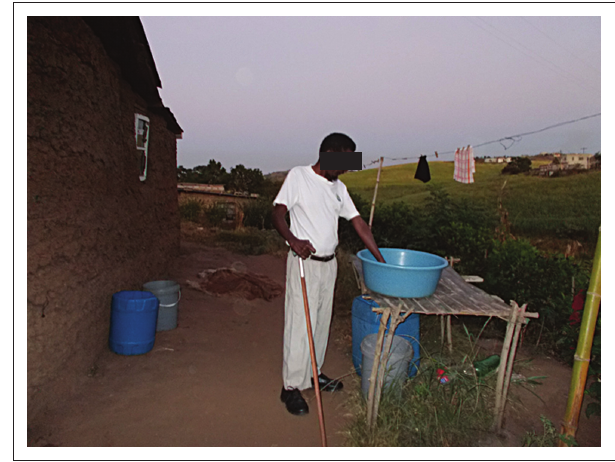
Source : D. Naidoo FIGURE 5: A physically disabled man finding adapted methods to complete his